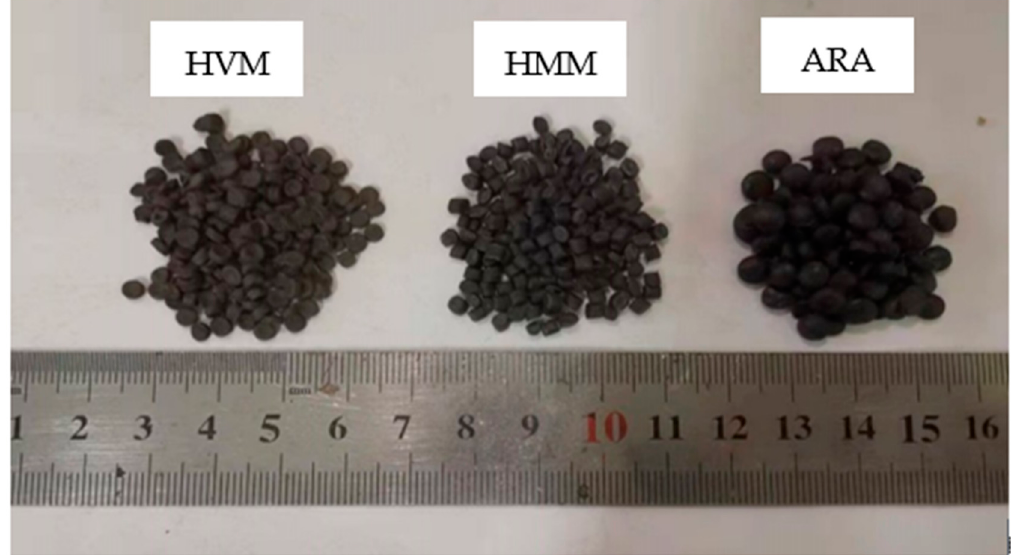
Figure 1. The appearance of the three modifiers. Table 1. Properties of additives.